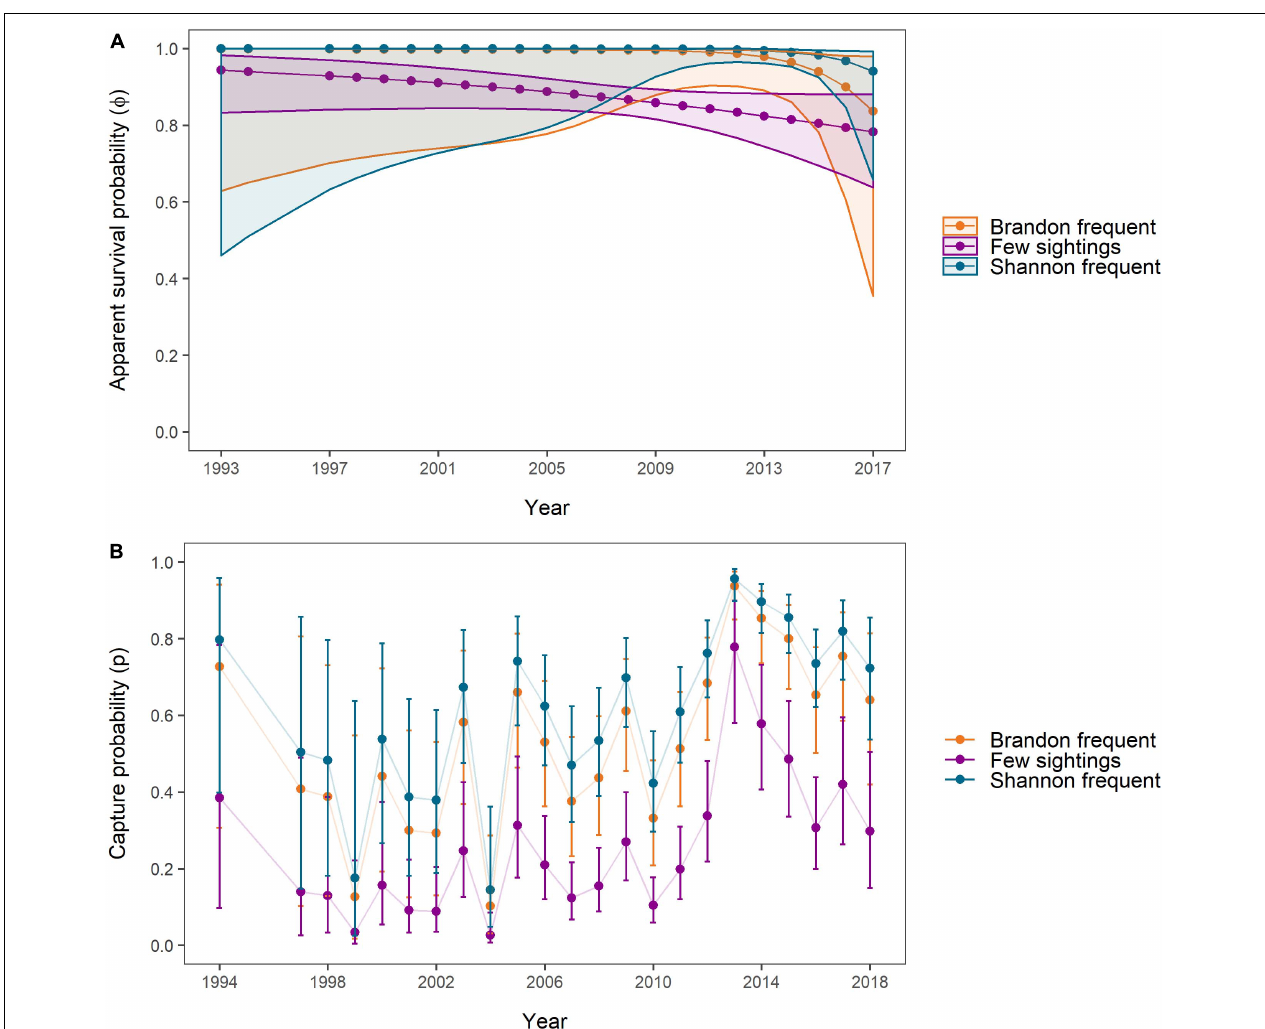
FIGURE 6 | (A) Apparent survival and (B) capture probabilities over the study period as estimated by and averaged for all Site Fidelity CJS models. Estimates were obtained for individuals frequently sighted in Brandon Bay ( n = 13, orange), individuals with few overall sightings ( n = 78, purple), and individuals frequently and almost exclusively sighted in the Shannon Estuary ( n = 50, blue). The correspondingly coloured polygons (A) and error bars (B) represent 95% confidence intervals around the estimates. No estimates for 1995/1996 were obtained due to lacking